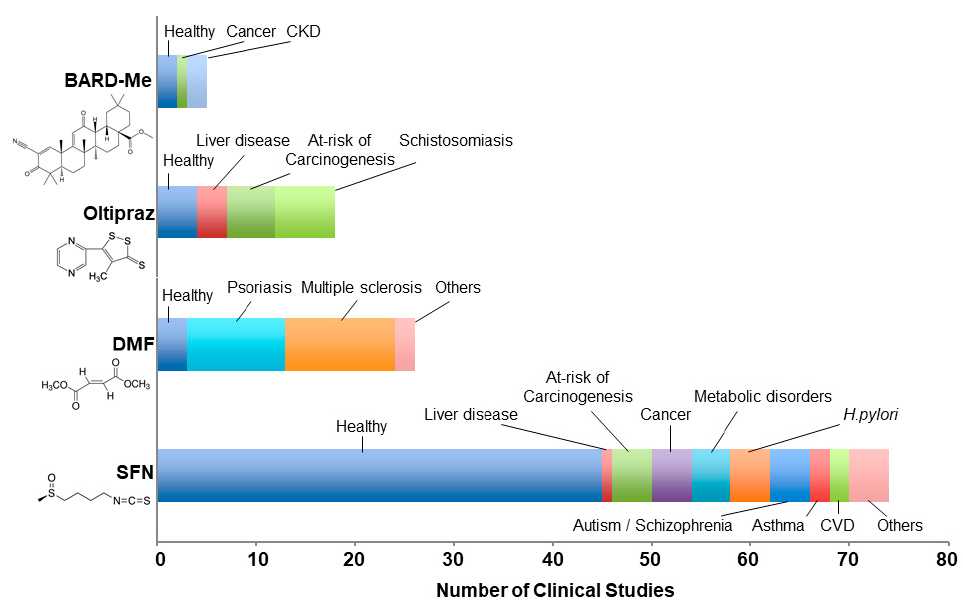
Figure 1. Study populations examined in peer-reviewed clinical studies of nuclear factor erythroid 2 related factor 2 (NRF2) inducers. Studies for bardoxolone methyl (BARD-Me), oltipraz, dimethyl fumarate (DMF), and sulforaphane (SFN) totaled 5, 18, 26, and 75, respectively, from 1982 to June 2020. Literature searches were conducted on PubMed, Google Scholar, and ClinicalTrials.gov. Publications based on the same clinical trial were aggregated as one study in this graph. The chemical structure for each NRF2 inducer is indicated below each name. CKD, chronic kidney disease; CVD, cardiovascular disease.